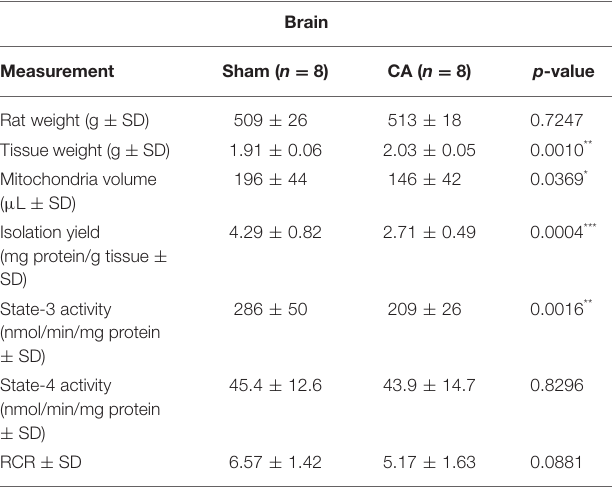
TABLE 1 | Basal characteristics and oxygen consumption rates of the isolated mitochondria from the brain.